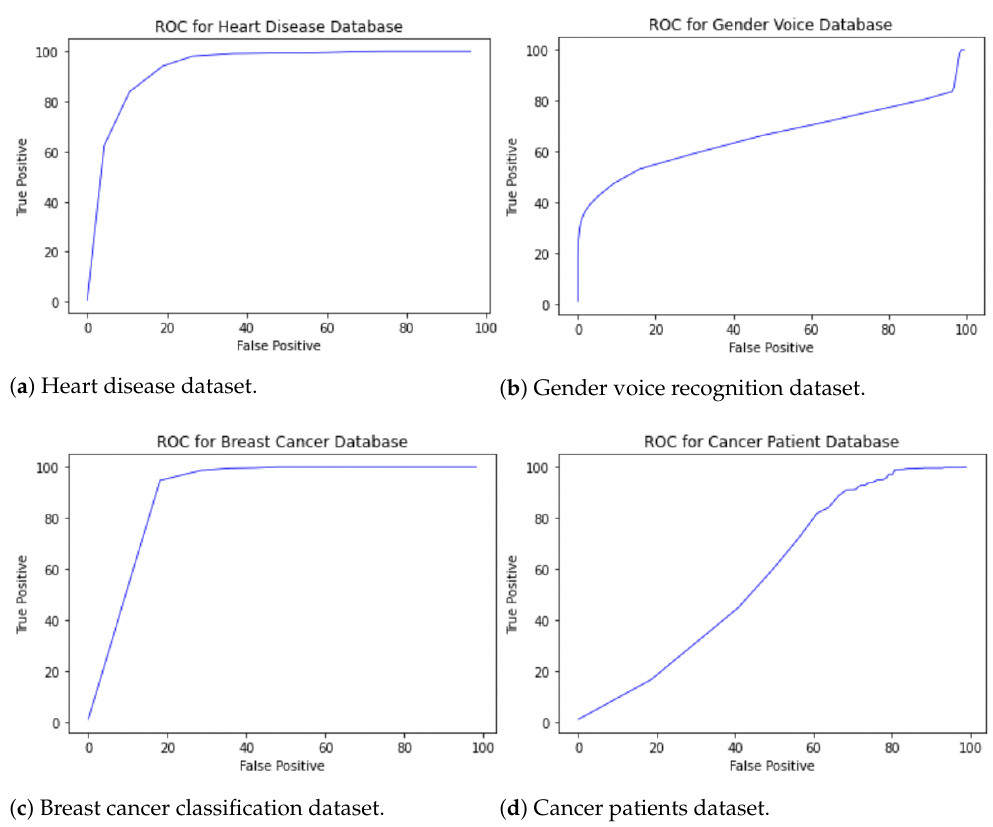
Figure 23. Receiver operating characteristic (ROC) curve.